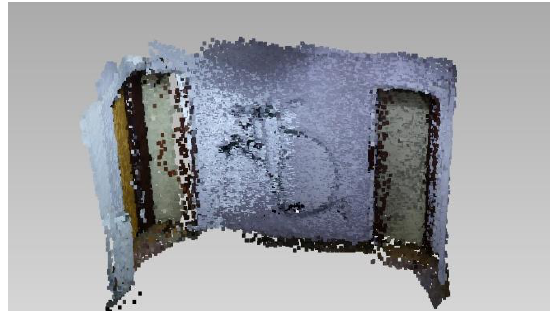
Figure 7 Coloured point cloud captured by the proposed